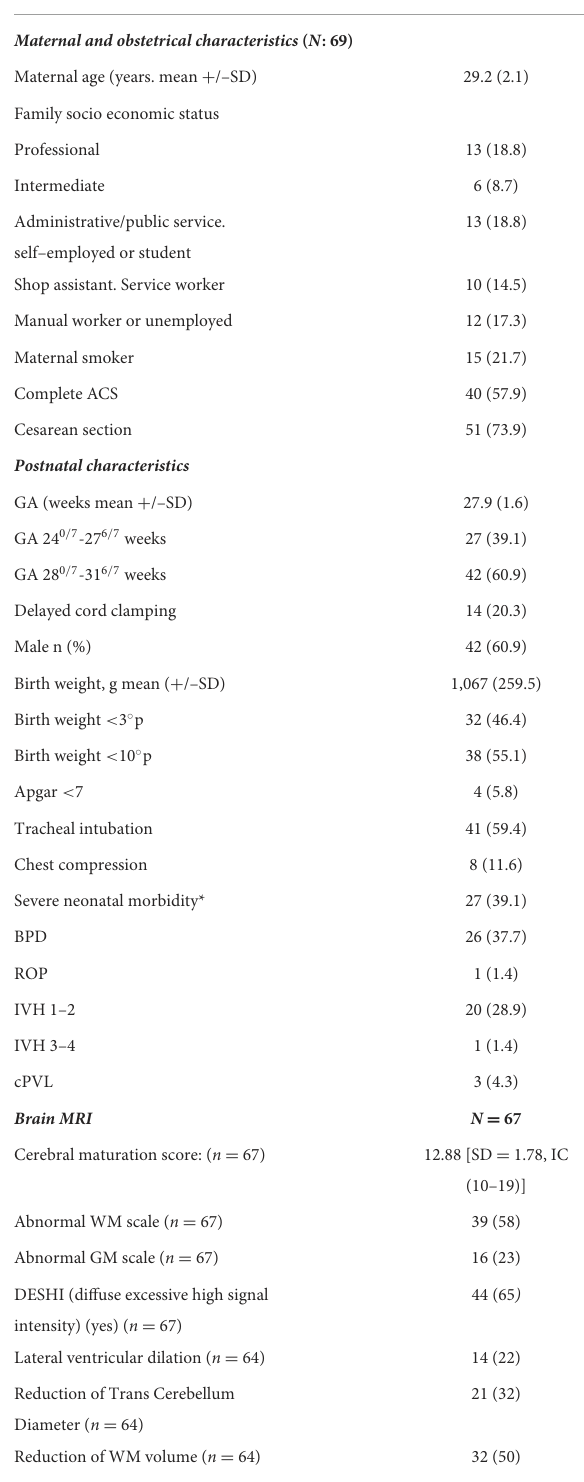
TABLE 1 Characteristics of the study